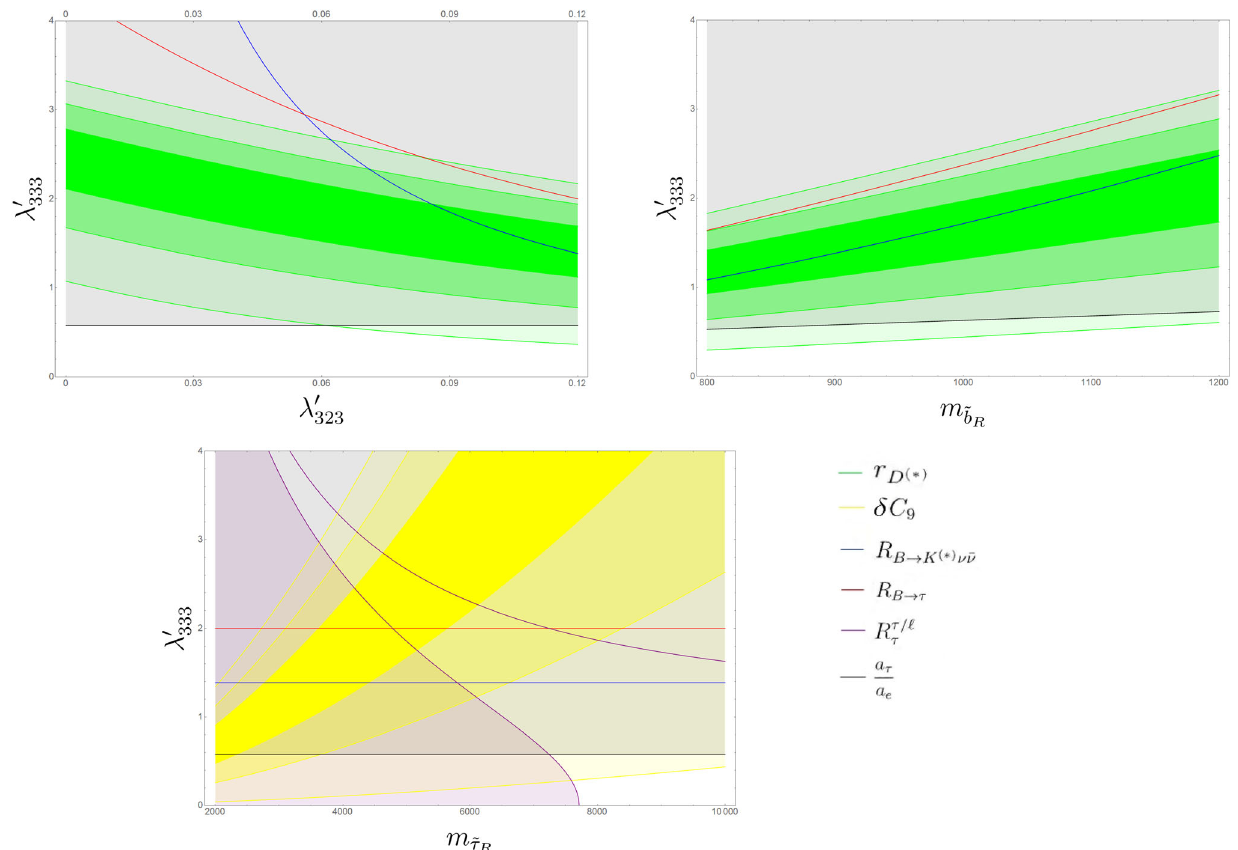
Fig. 2 RPV parameter space accommodating r D ( ∗ ) (green) and δ C 9 (yellow) at 1 σ , 2 σ and 3 σ around the best-fit point. The constraints originating from the following observables: R B → K ( ∗ ) ν ¯ ν (blue), R B → τ ¯ ν (red), R excluded at 2 σ